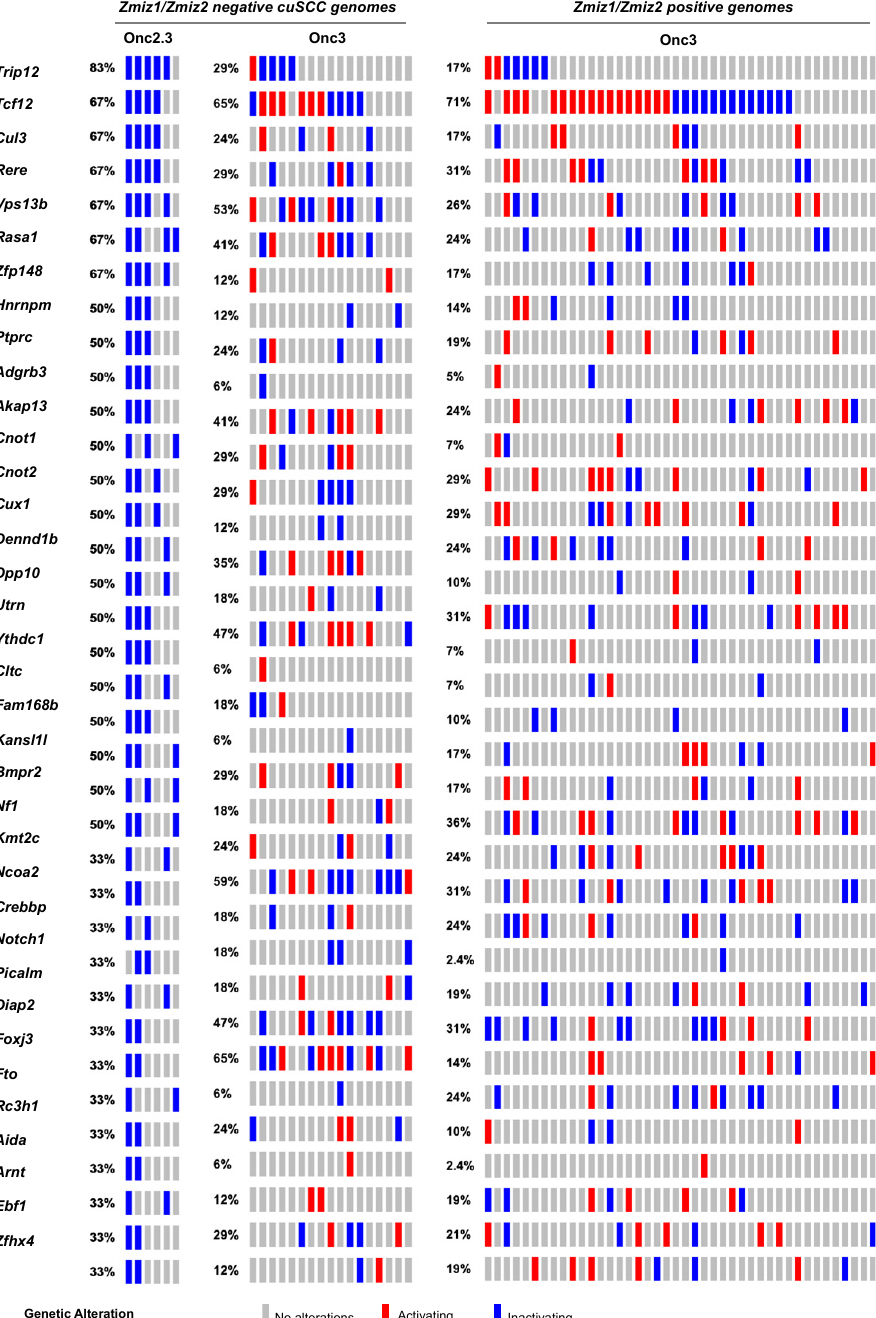
Figure 2. SB-driven cuSCC by cumulative tumor suppression. Recurrent inactivating SB insertions in Onc2.3-induced cuSCC genomes (n = 6). Comparative waterfall plots of trunk driver genes from Zmiz1 / Zmzi2 -independent SB-Onc2.3 and SB-Onc3 (n = 23 (left)) and Zmiz1 / Zmzi2 -dependent SB-Onc3 (n = 43 (right)) cuSCC tumors. ( c ) Zmiz1 / Zmiz2 -independent tumor segregated by SB cohort, SB-Onc3 (n = 17 (left)) and SB-Onc2.3 (n = 6 (right)).